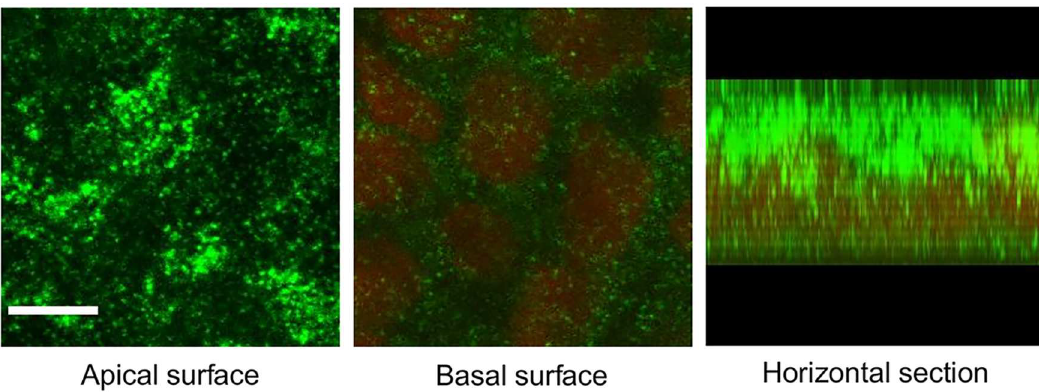
Fig 1. Melanocortin-1 receptor(MC1R) expressionin Caco-2 cells. Cells were grown into confluentmonolayers for 21 days on culture inserts and immunostained for MC1R. Nuclei were labeledwith propidiumiodide. Optical sections